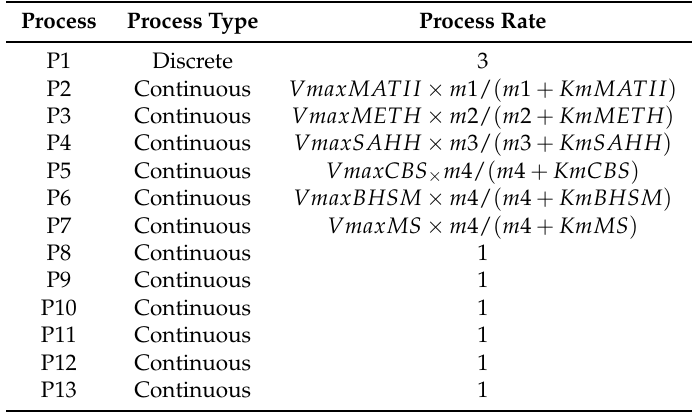
Table 2. Correspondence between HFPN processes and reaction velocities.